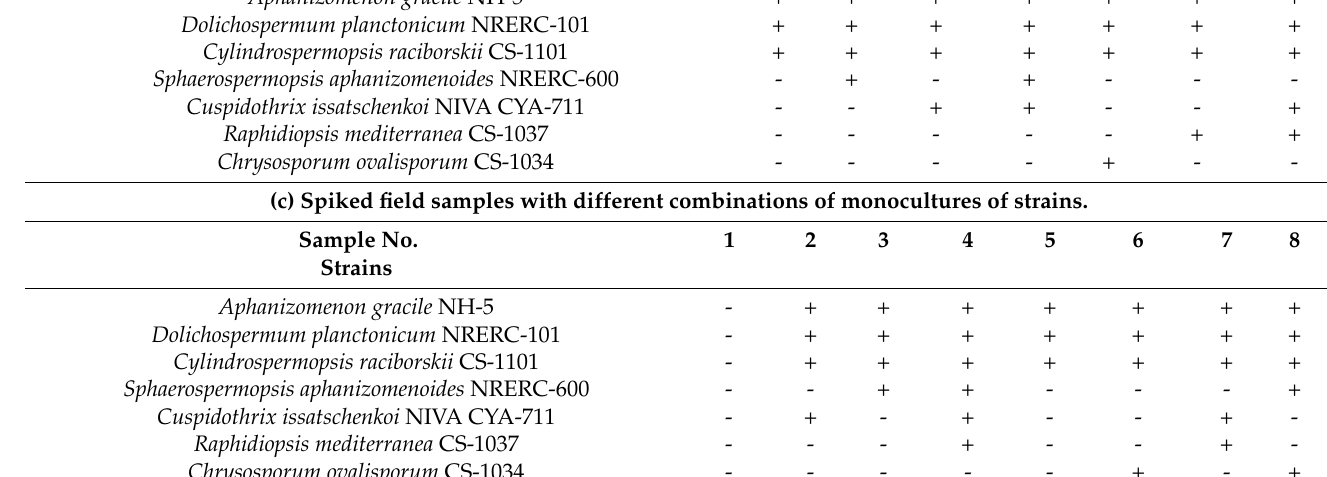
(c) Spiked field samples with different combinations of monocultures of